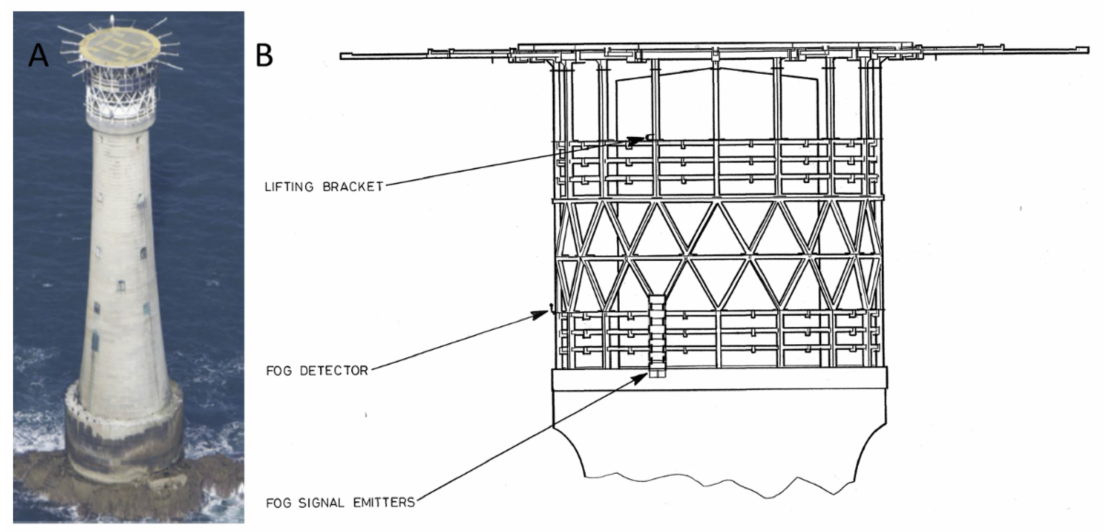
Figure 2. ( A ): Bishop Rock lighthouse (courtesy of Trinity House). ( B ): The helideck general assembly (courtesy of Trinity